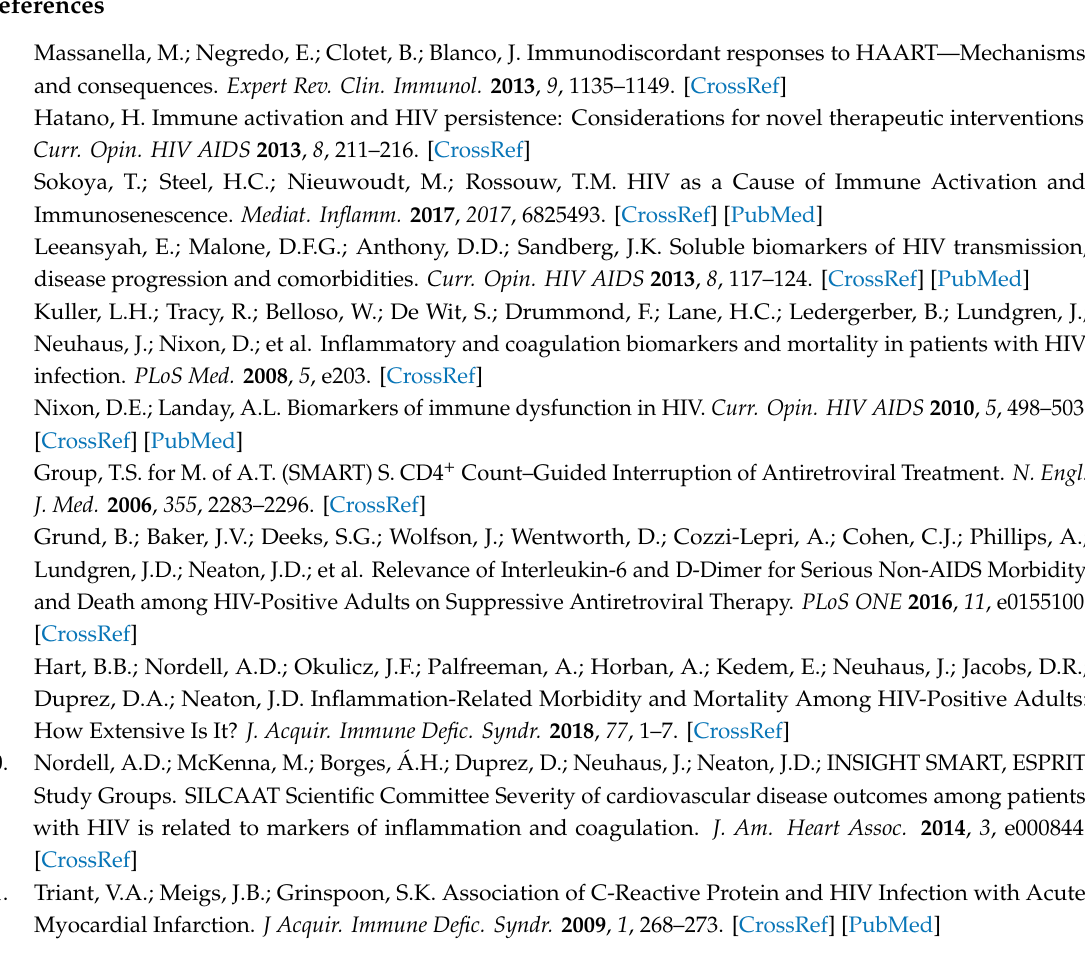
Figure S1: Random forest analysis, Table S1: Spearman correlation coe ffi cients between basal glycoproteins and final CD4 + T-cells (144